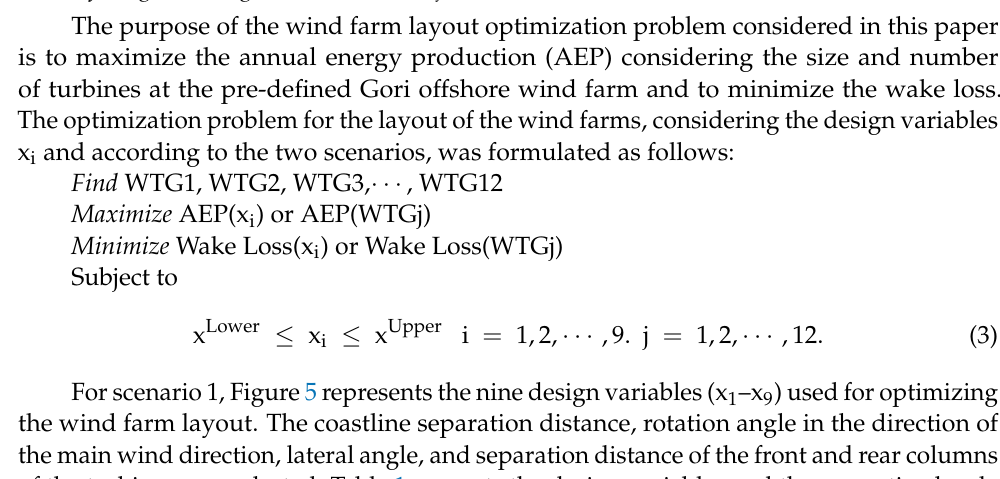
Figure 6. Design variables for offshore wind farm layout based on unrestricted coordinates (scenario 2). The program was run by entering the turbine interval, site size, number of turbines, output file name, and sampling method in the command window. The results of the pro- gram execution were checked in the .csv file, as displayed in Excel. The intervals for the x and y coordinates of the two accumulated turbines were set to at least 4D of the turbine diameter and defined using the following expression [12,22,23]: ∑ ∑ (cid:3493)((cid:1876) (cid:3036) − (cid:1876) (cid:3037) ) (cid:2870) + ((cid:1877) (cid:3036) − (cid:1877) (cid:3037) ) (cid:2870)(cid:3015) (cid:3037)(cid:2880)(cid:3036)(cid:2878)(cid:2869)(cid:3015)(cid:2879)(cid:2869) (cid:3036)(cid:2880)(cid:2869) ≤ 4(cid:1830) .